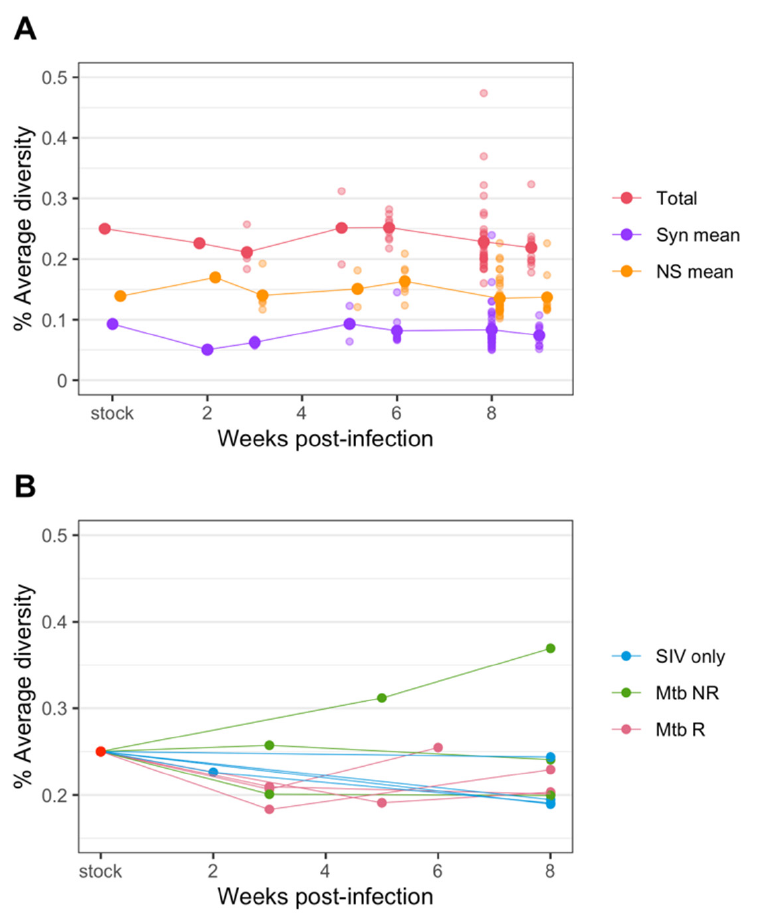
Figure 4. Changes in diversity of SIV env over the course of infection in plasma. ( A ) The average diversity of SIV of all samples at each time point. The total diversity (red) as well as diversity from synonymous (purple) and nonsynonymous changes (orange) are plotted. ( B ) The SIV average diversity of plasma samples only, colored by cohorts.